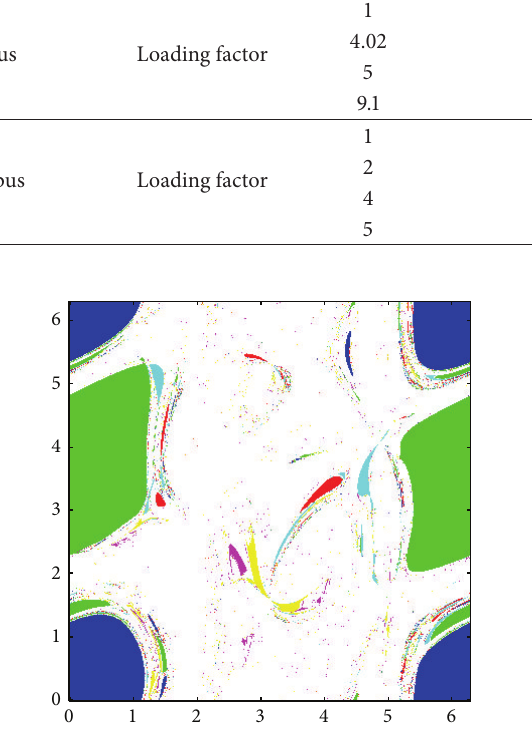
Figure 4: Convergence region of power flow solutions of the IEEE 14-bus system on ( 𝜃 2 ,𝜃 3 ) plane.